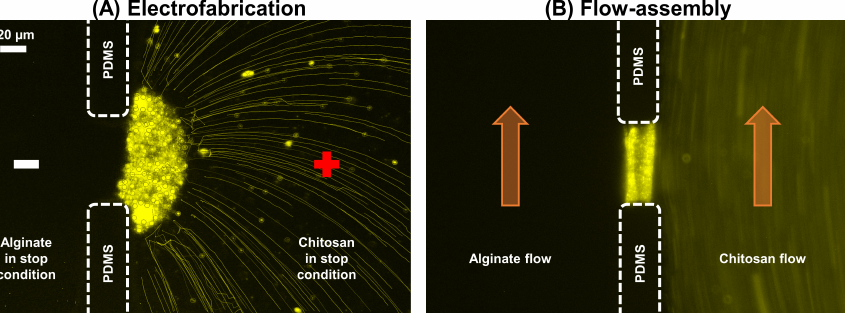
Figure 7. Growth mechanisms of chitosan membranes in the two fabrication approaches. ( A ) In electrofabrication, chitosan chains (anode side) were attracted towards the PECM in the vertical direction, followed by gelation with the flux of hydroxyl ions from the alginate (cathode) side driven by electrical stimuli. ( B ) In flow assembly, chitosan chains were assembled layer by layer along the flow direction and in parallel with the PECM, where the polymerization was induced by the diffusion of hydroxyl ions from the alginate side driven by laminar flows.